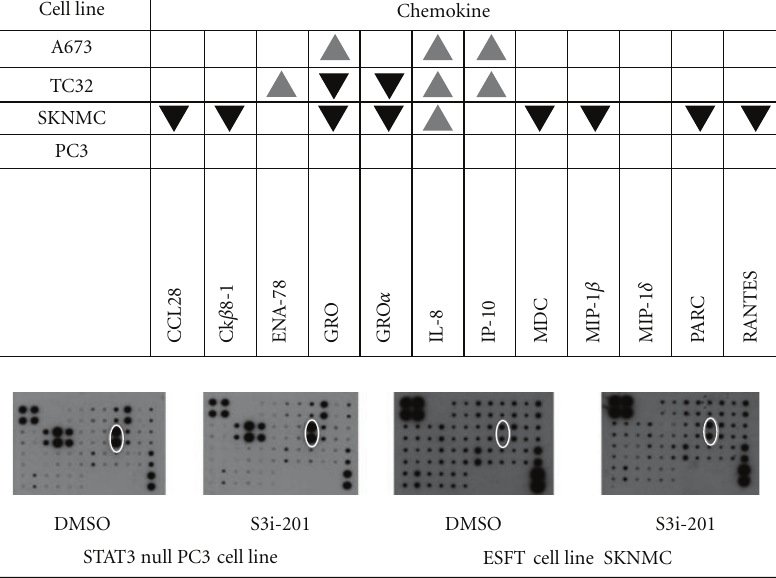
Figure 3: STAT3 inhibition in ESFT cells alters the levels of a limited number of chemokines. Upper panel the gray up-pointing triangle denotes an increase, and the black down-pointing triangle denotes a decrease, of more than 10%, observed in two independent experiments for each cell line. The changes represent a ratio of density values, comparing arrays of STAT3-inihibited cells with arrays of DMSO-treated cells. Lower panel examples of arrays performed on supernatants of STAT3 null control cells (PC3) and the ESFT cell line SKNMC, cultured in the absence (DMSO treatment) or presence (S3i-201 treatment) of STAT3 inhibition. C κβ 8-1 = CCL23, ENA-78 = CXCL5, GRO = pan marker for GRO family chemokines, GRO α = CXCL1, IL-8 = CXCL8, IP-10 = CXCL10, MDC = CCL22, MIP-1 β = CCL4, MIP-1 δ = CCL15, PARC = CCL18, and RANTES =